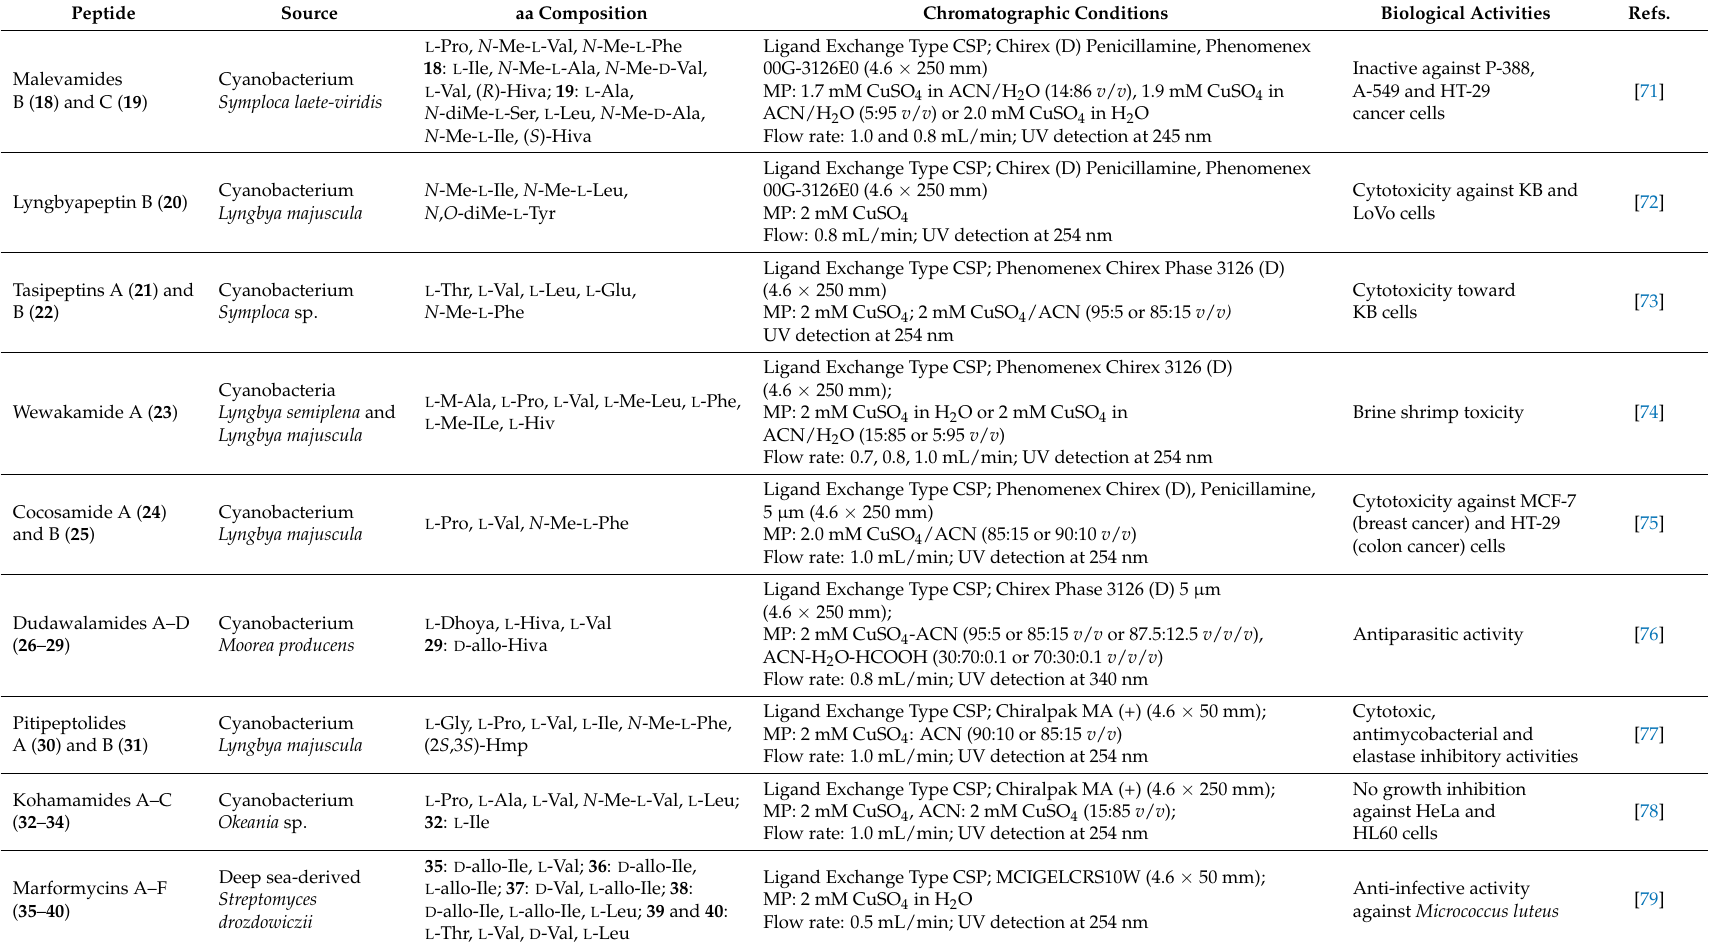
Table 2. Cyclic depsipeptides from marine cyanobacteria and other